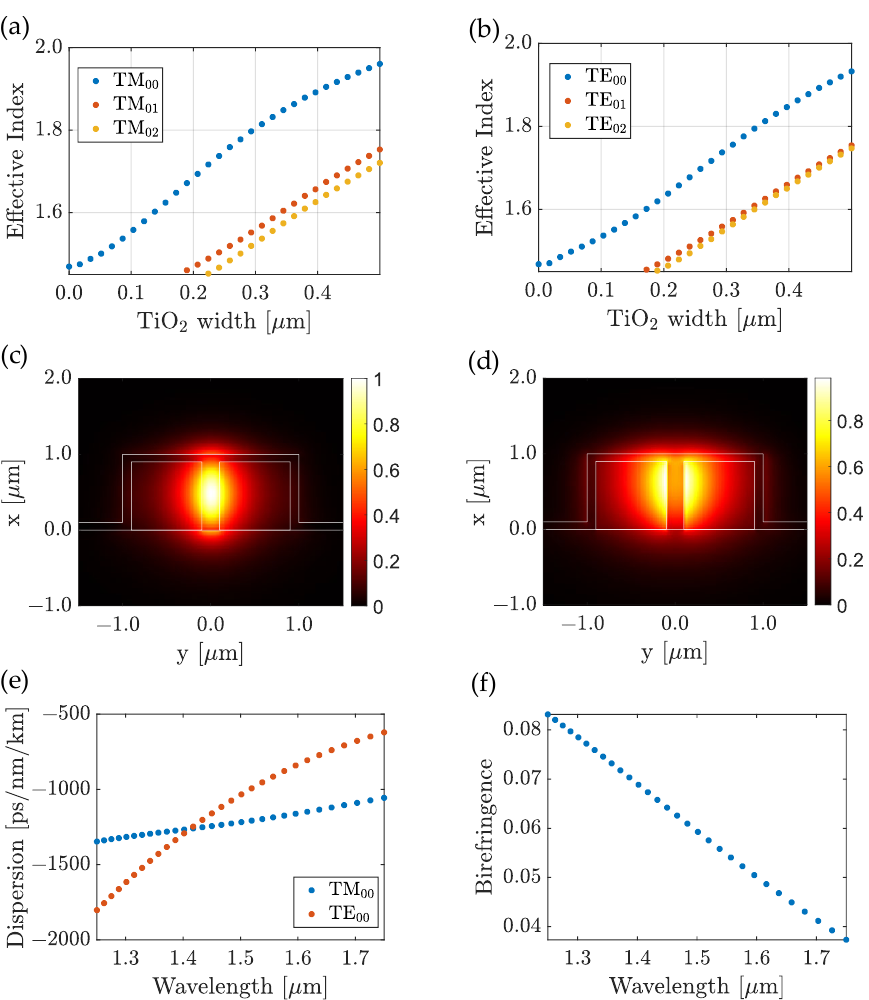
Figure 5. Waveguide structure design. ( a , b ) Effective index as a function of the TiO 2 thickness t for quasi-TM and quasi-TE polarizations, respectively. ( c , d ) TM 00 and TE 00 mode distributions, respectively. ( e ) Dispersion of the TM 00 (dotted red curve) and TE 00 (dotted blue curve) modes. ( f ) Birefringence.